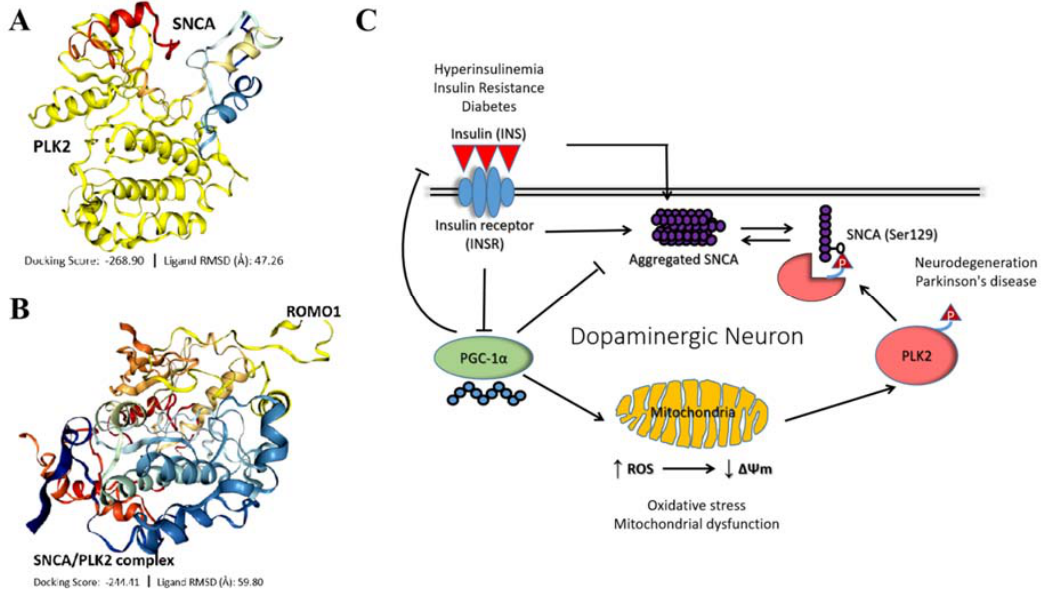
Figure 7. IR-driven SNCA-PLK2-reactive oxygen species (ROS) signaling is implicated in PD development and progression. Molecular docking showing direct interaction between ( A ) SNCA and PLK2 with shape complementarity / docking score of –268.90, and ligand root-mean-square deviation (RMSD) of 47.26Å and ( B ) SNCA-PLK2 complex and reactive oxygen species modulator 1 (ROMO1) with a docking score of –244.41, and ligand RMSD of 59.80Å. ( C ) Schematic abstract illustrating an association between IR and PD, with IR promoting PD through aberrant expression of SNCA, enhanced mitochondrial oxidative stress, mitochondrial dysfunction, and deregulation of the PLK2